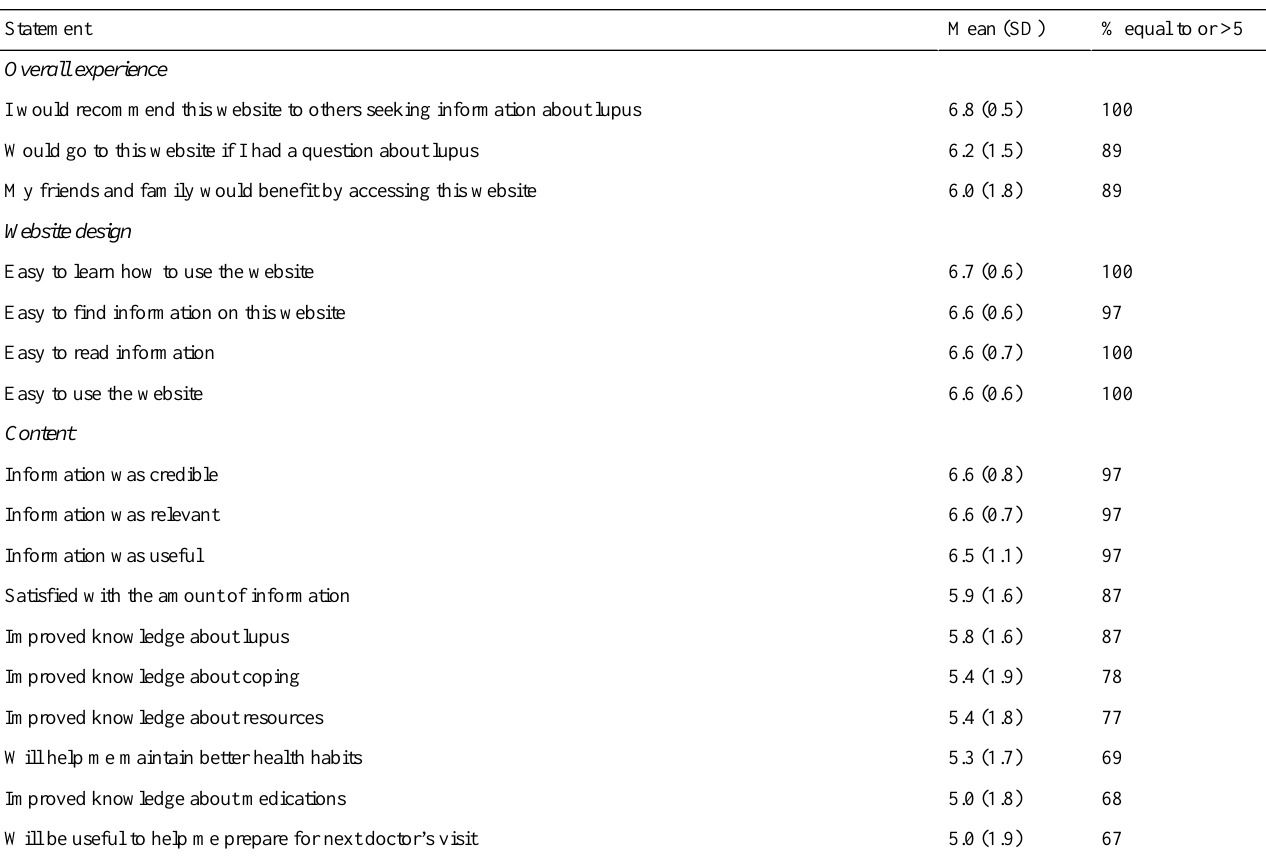
Table 3. Ratings of website usability and content based on 37 participants (1=strongly disagree; 7=strongly